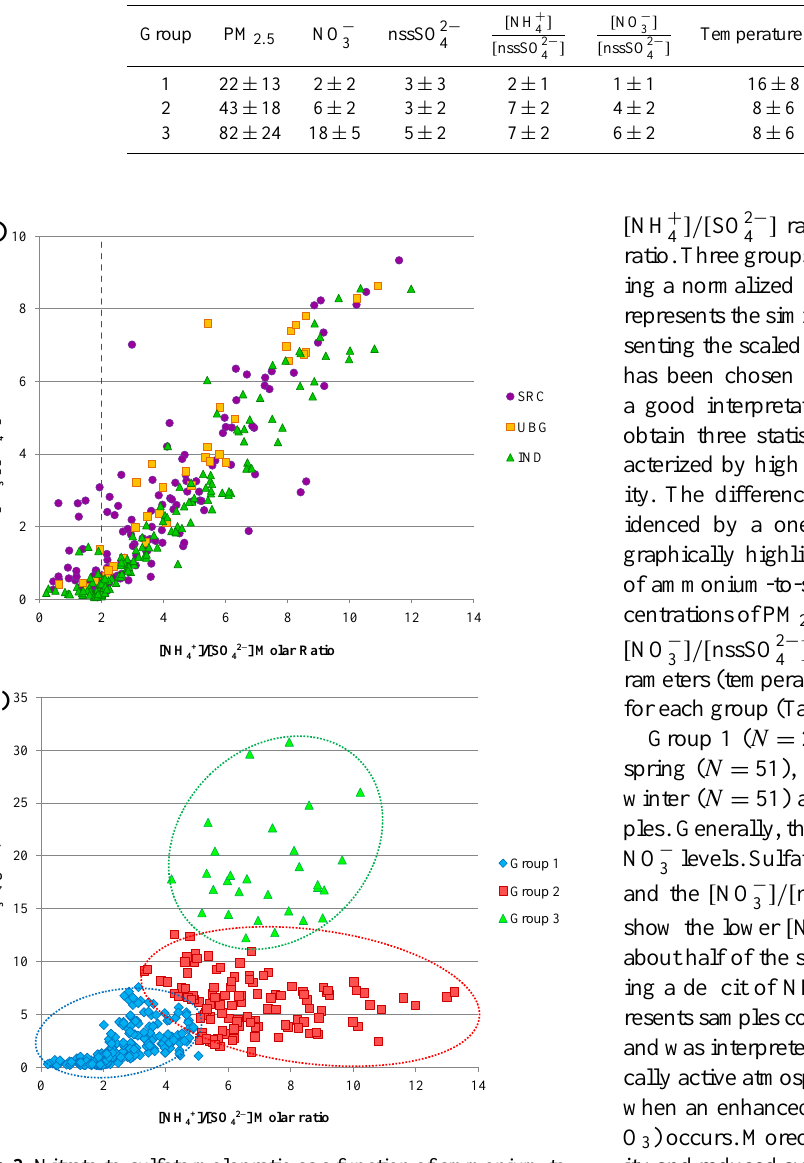
Fig. 3. Nitrate-to-sulfate molar ratio as a function of ammonium-to- sulfate molar ratio (a) and nitrate-to-sulfate molar ratio as a function of nitrate showing the differences among the groups identified by the cluster analysis (b)